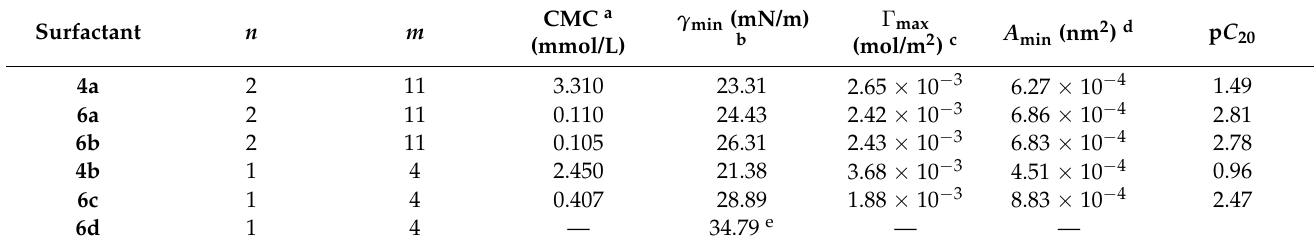
a Critical micelle concentration. b Lowest surface tension measured. c Maximum surface excess con- centration. d Minimum area per surfactant molecule. e Surface tension of 6d at 0.1 mmol/L.